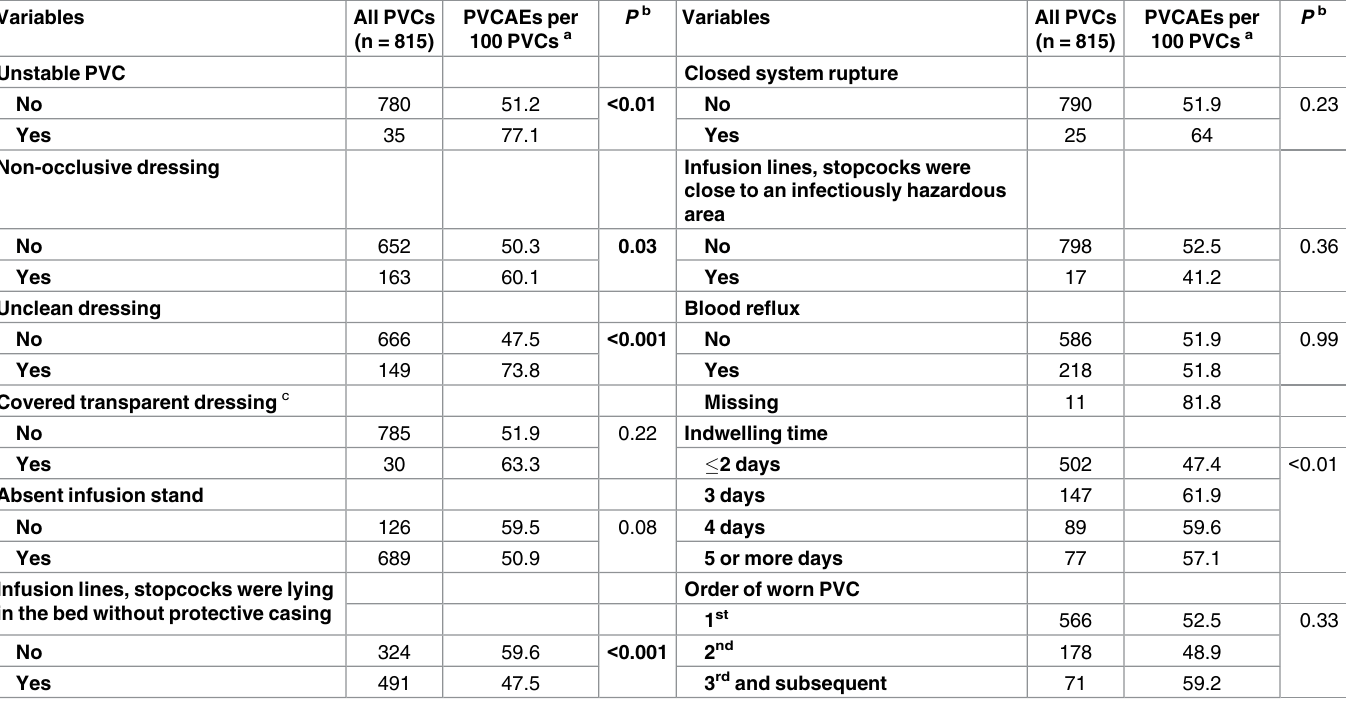
Table 6. Incidence of at least one PVCAE according to practice-mirroring variables in univariate analysis, n = 815 PVCs. Variables